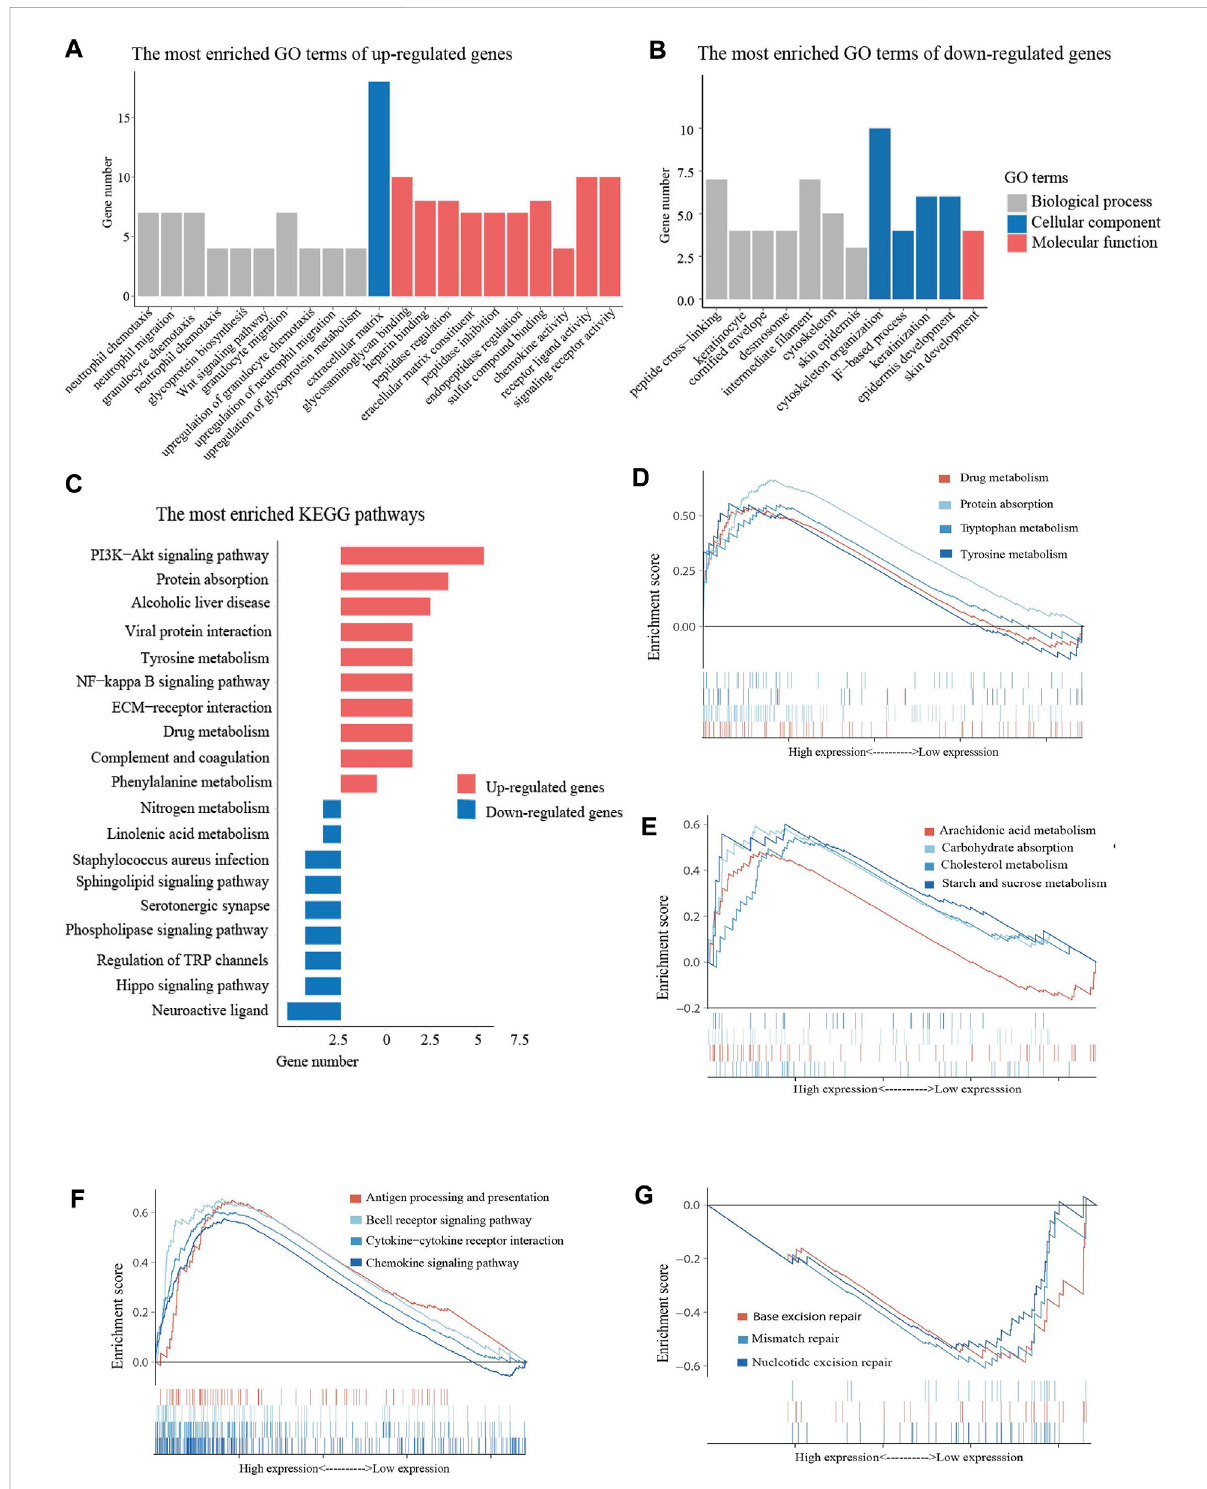
EnrichmentanalysisofDEGs (A) ThemostenrichedGOtermsofup-regulatedDEGs. (B) ThemostenrichedGOtermsofdown-regulatedDEGs (C) The bar graph of the most enriched KEGG pathways. (D,E) Metabolism related pathways in GSEA enrichment analysis (F) Immunity